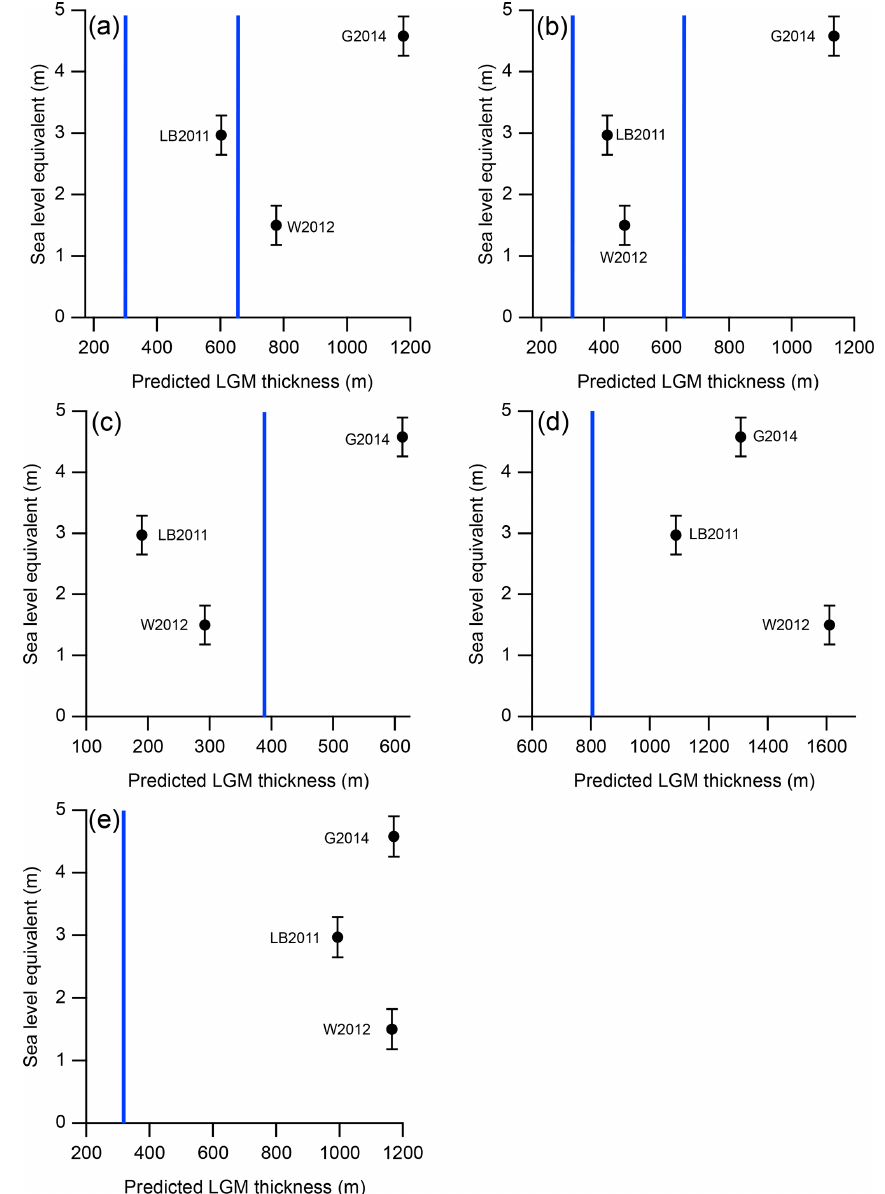
Figure 12. Predicted LGM ice thickness change from three ice sheet model outputs at each of our study sites and their associated sea level equivalent (SLE) for the Weddell Sea Embayment (WSE) sector of the Antarctic ice sheet. (a) is Mt Skidmore, (b) Mt Provender, (c) the Lassiter Coast, (d) Schmidt Hills, and (e) Thomas Hills. Vertical blue lines show the interpreted LGM thickness change at each site based on our in situ 14 C data. For (a) and (b) , the two vertical blue lines show the range of thickness estimates for the two sites, with the upper limit constrained by the highest elevation saturated sample at Mt Provender. “G2014” refers to Golledge et al. (2014), “LB2011” refers to Le Brocq et al. (2011), and “W2012” refers to Whitehouse et al. (2012). Errors are not provided for the model outputs. The average error of published SLEs associated with model outputs for the entire ice sheet is 1.45m (see Simms et al., 2019). We therefore use an error of 0.3m for the three model SLEs, which is 22% of the average error (22% is the proportion of the AIS that the WSE drains; see Joughin et al.,